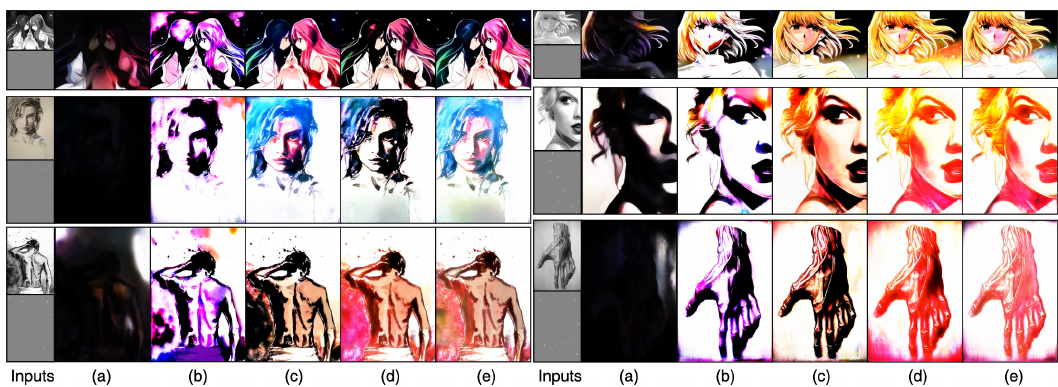
Figure 10. Visual comparison of include grayscale. ( a ): Base [10], ( b ): Pix2pix [2], ( c ): ours (LDM enabled line loss only), ( d ): ours (histogram equalization only), ( e ): ours (Both: LDM enabled line loss + histogram equalization).